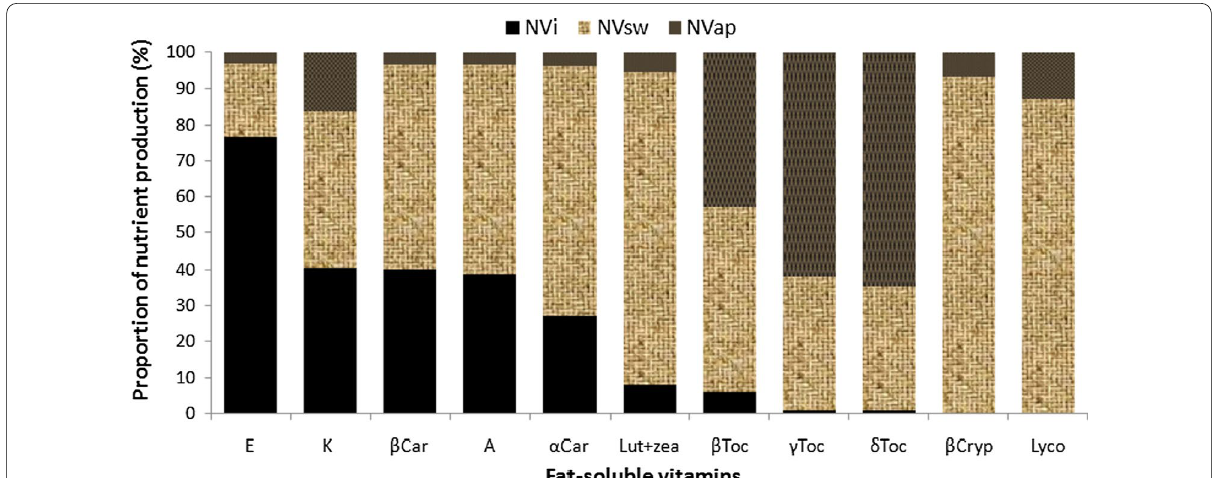
Fig. 3 Proportion of fat-soluble vitamins in national crop production attributed to pollinator-independent crops, self- or wind pollination and animal pollination. E βToc β-tocopherol, γToc =